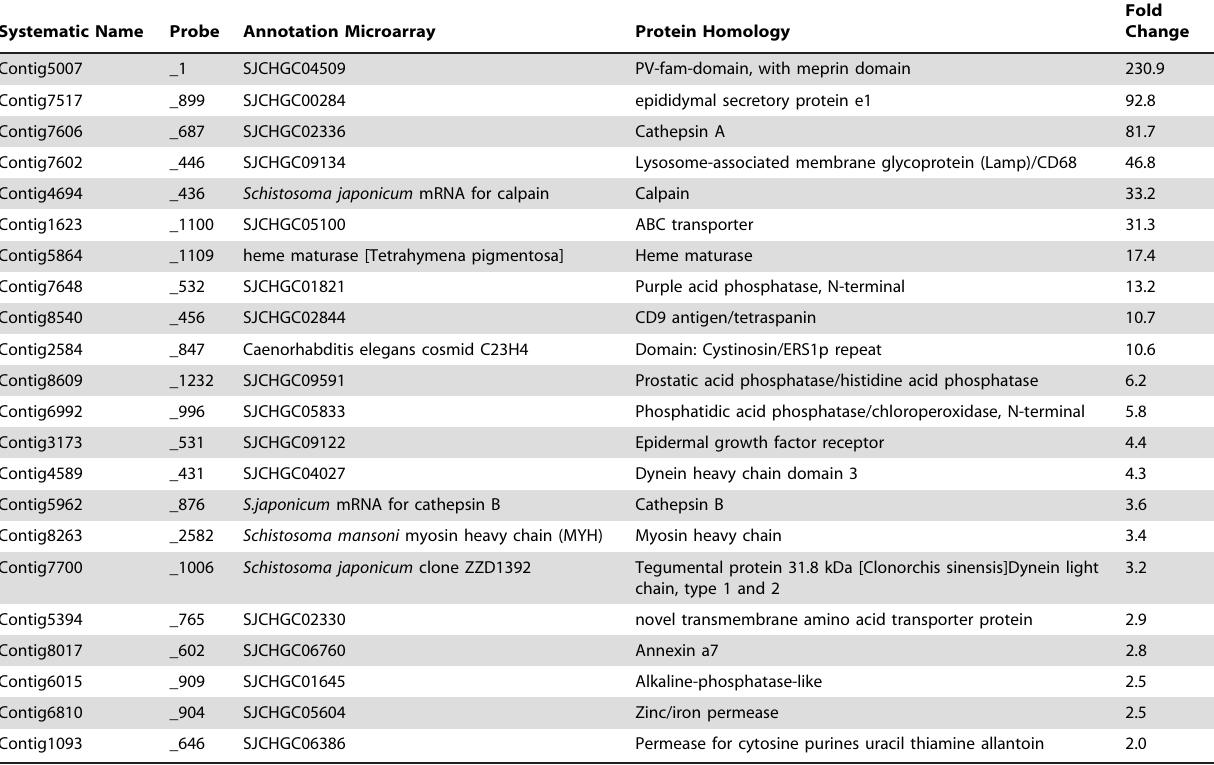
Table 1. Examples of differentially expressed genes of the gastrodermis of S. japonicum normalised to signal intensity of the vitelline and ovary